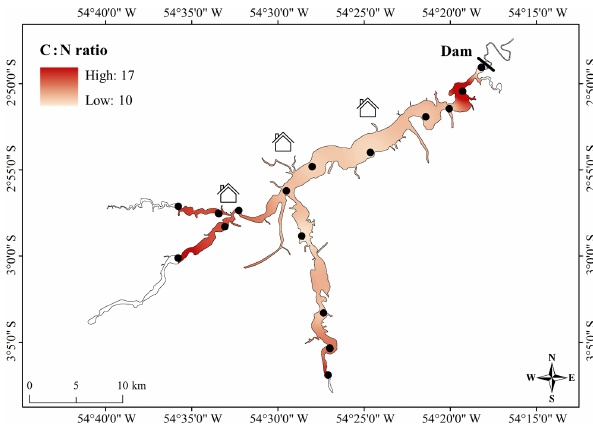
Figure 2. C : N ratio of surface sediment in Curuá Una reservoir. The black dots represent the sampling sites. The houses represent the settlements at the